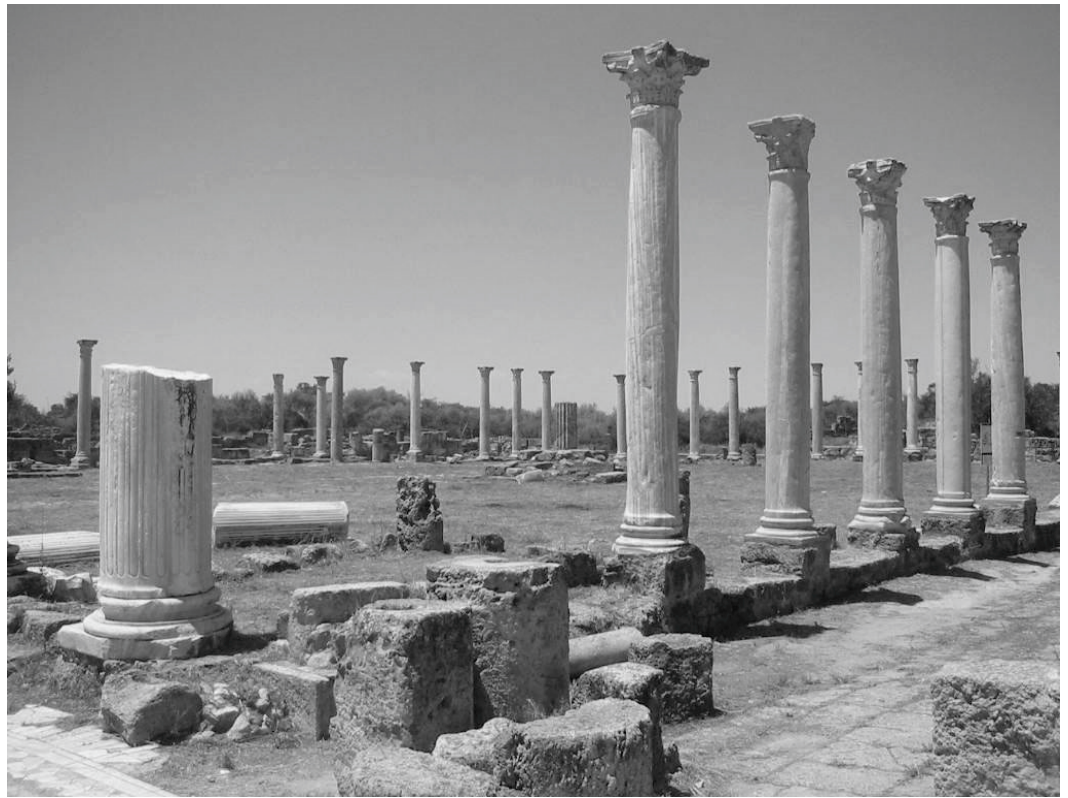
Figure 7. The Salamis gymnasium palaestra showing the imported marble colonnade. Photograph by J.M. Gordon. J.M.